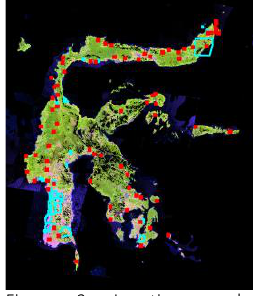
Figure 2. Locations and numbers of high resolution imagery (closed red squares) for Sulawesi shown on 2008 Landsat TM mosaics (bands 3, 4, 5 in BGR).